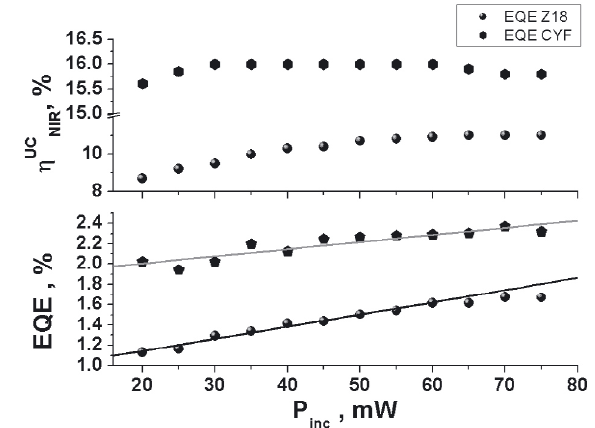
Fig. 9. Excitation power dependence of EQE and the IR → NIR absolute conversion